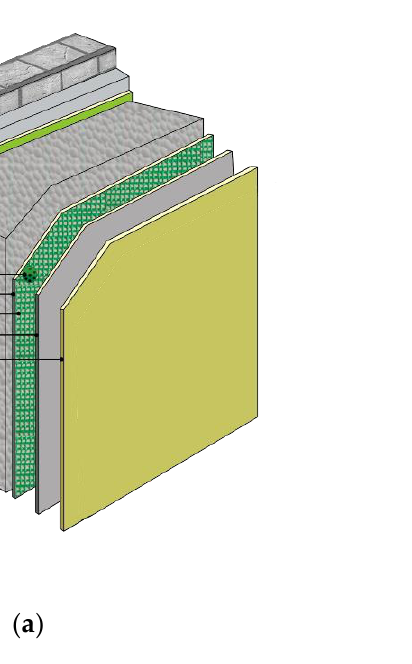
Figure 1. Schematic diagram. ( a ) A typical insulation wall in China. 1-AAB wall, 2-plastering mortar layer, 3-adhesive layer, 4-exterior insulation layer, 5-anchor bolt, 6-crack resistant glue, 7- fiberglass mesh, 8- crack resistant glue, 9- flexible water resistant putty; ( b ) form of the thermal bridge.